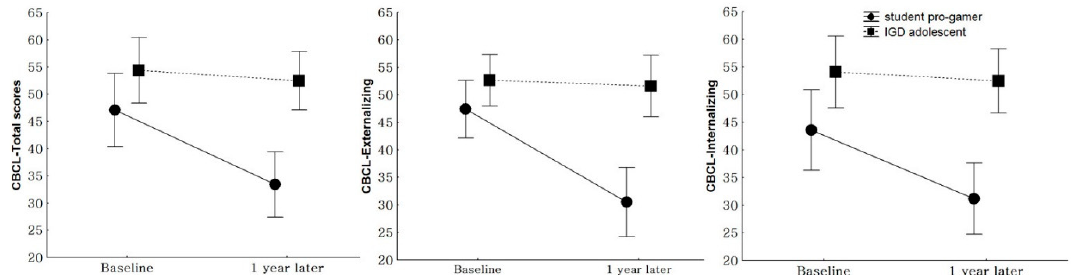
Figure 1. Comparison of the changes in the CBCL between student pro-gamer and IGD adolescent